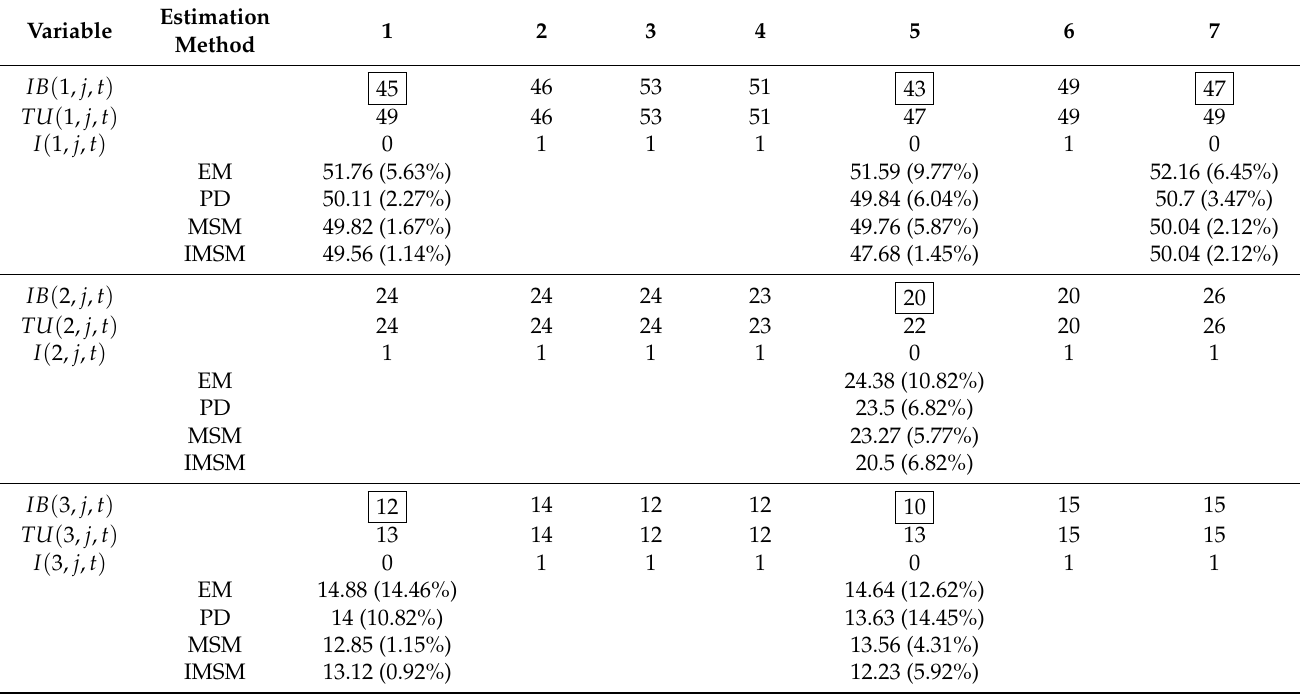
Table 6. Repair results and errors analysis of 1